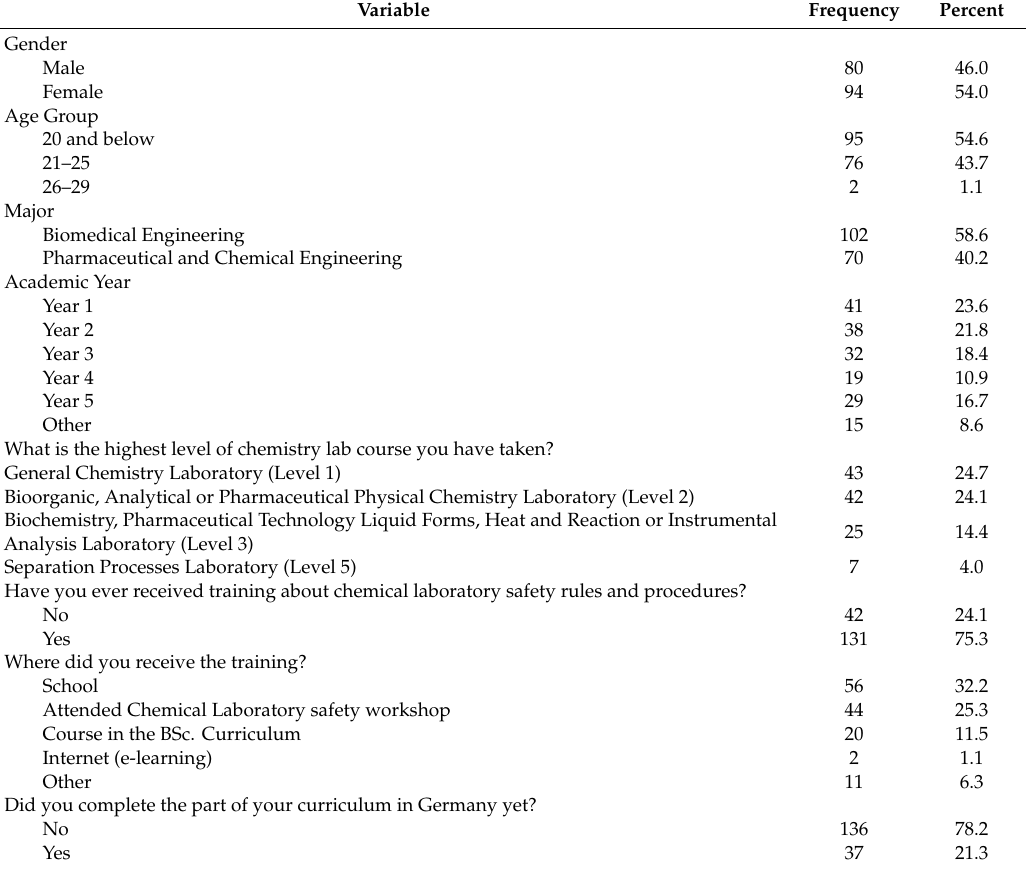
Table 1. Frequency distribution of students by demographics.